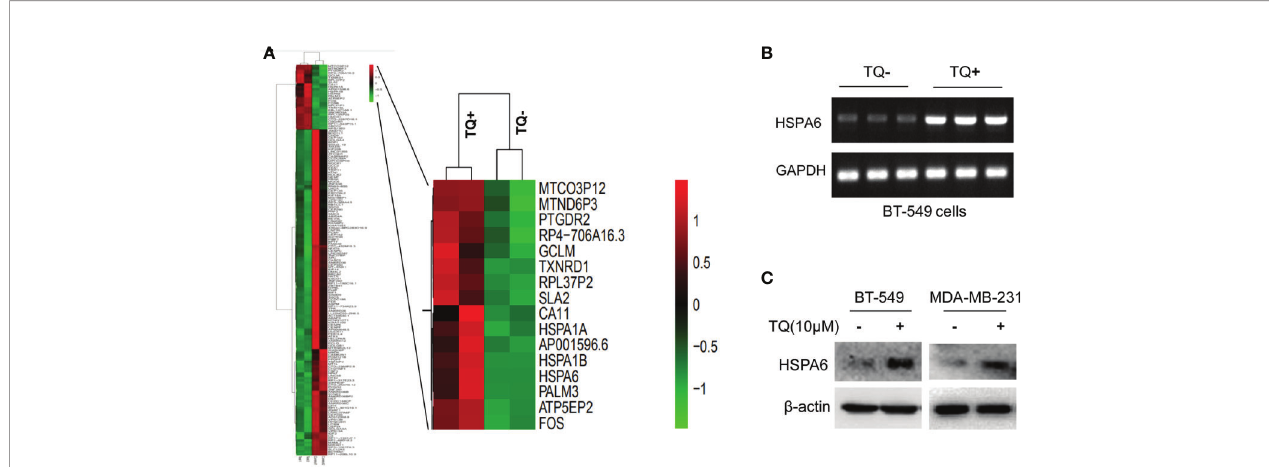
FIGURE 1 | HSPA6 is a novel target by TQ regulation. (A) Clustering of differential genes from RNA-sequencing (RNA-seq) data with and without TQ treatments in TNBC BT-549 cells. Left panel, the heatmap of RNA-seq shows all signi fi cantly upregulated and downregulated genes after treated by TQ; right panel, the heatmap of RNA-seq shows part of signi fi cantly upregulated genes after treated by TQ. Red indicates highly expressed genes whereas green indicates lower expressed genes. A horizontal (X) axis presents different samples whereas a vertical (Y) axis presents the name of gene. The mRNA levels (B) and protein levels (C) for HSPA6 are increased by treatment with TQ for 6 h in the indicated breast cancer cell lines. The GAPDH and b -actin were set as internal controls for mRNA and protein